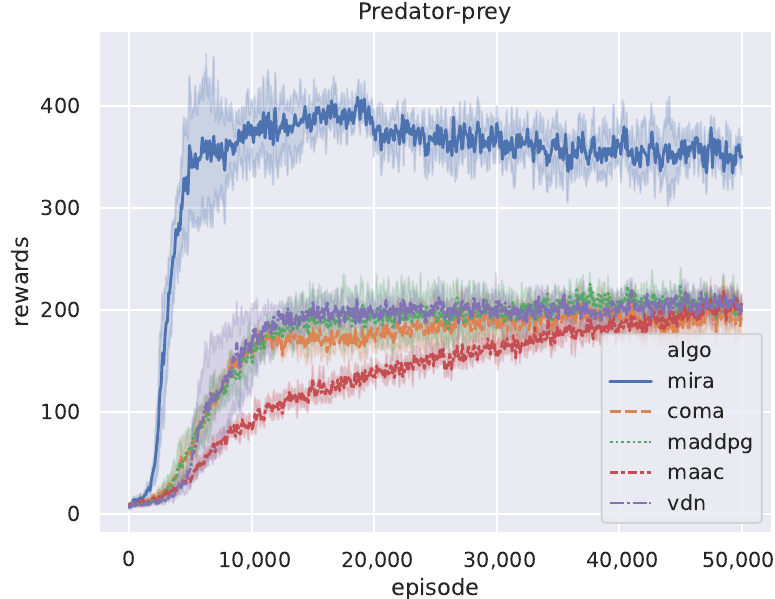
Figure 4. The training process of MIRA and four CTDE baselines on the predator-prey benchmark. The evaluation results of the metrics in the predator-prey case are shown in Table 2. The overall performance of MIRA is substantially better than other compared algorithms.